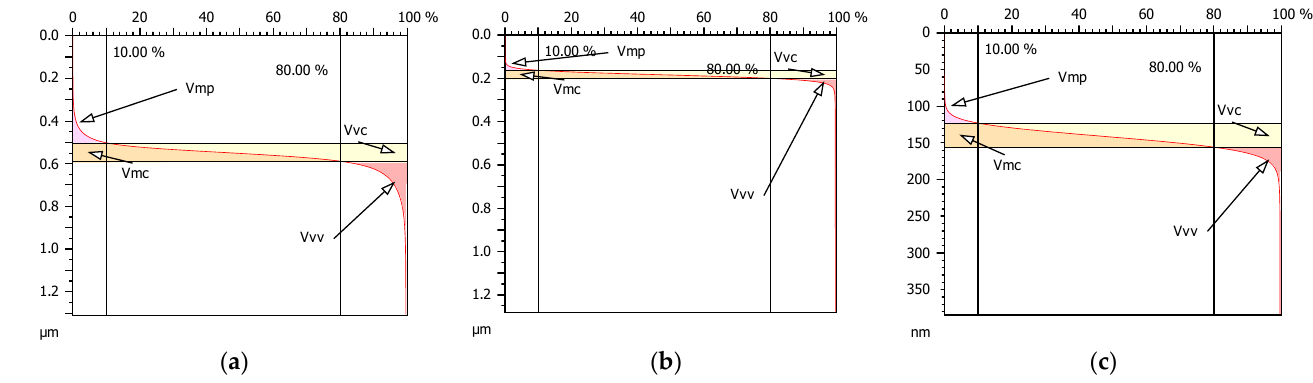
Figure 17. Graphic presentation of volume parameters of surfaces: base no. 1 ( a ), modified no. 2 ( b ) and modified no. 3 ( c ).